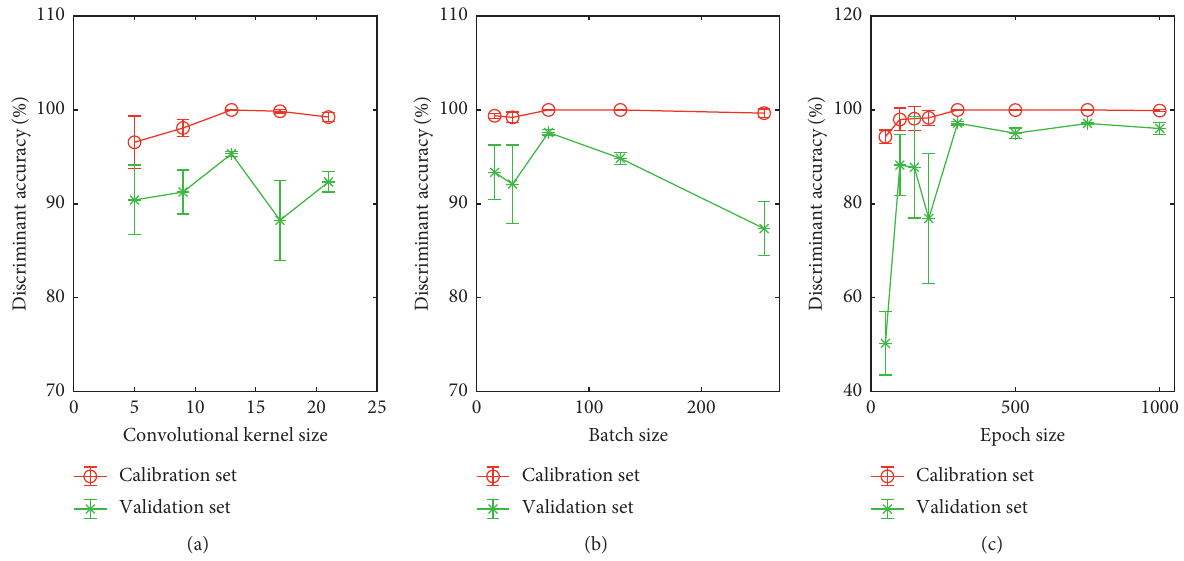
Figure 4: Parameters tuning of CNN model: (a) convolutional kernel size, (b) batch size, and (c) epoch